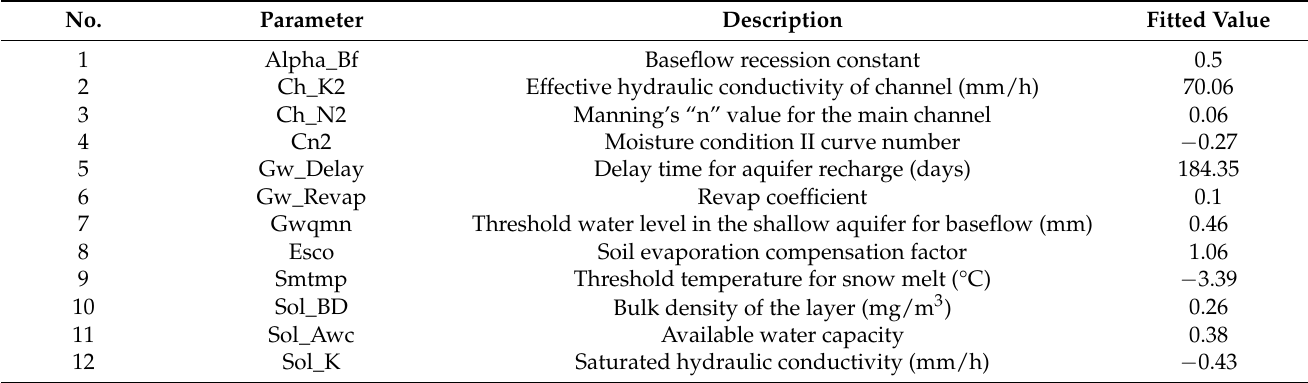
Table 6. Description of runoff calibration